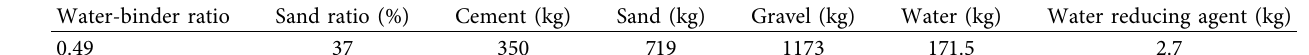
Table 2: Concrete mix